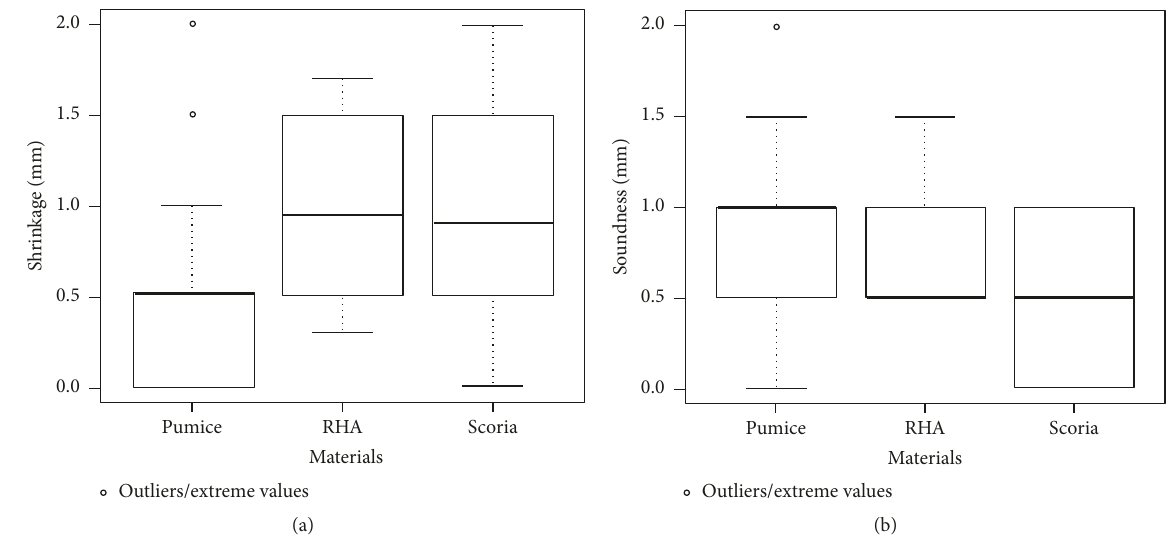
Figure 6: Effect of materials on (a) shrinkage and (b) soundness.